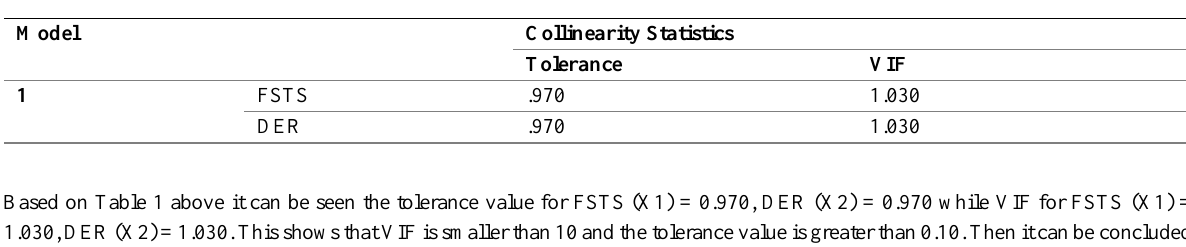
Table 1: Multicollinearity